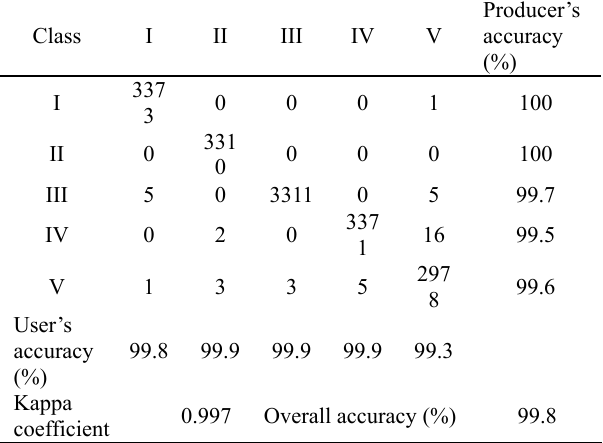
Table 2. Confusion matrix, statistical measures and kappa coefficient for simulated SAR images.